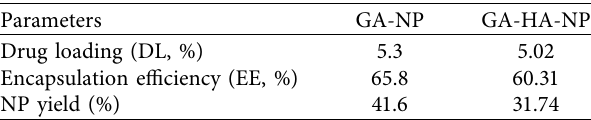
Table 4: Drug loading capacity, encapsulation efficiency, and yield of